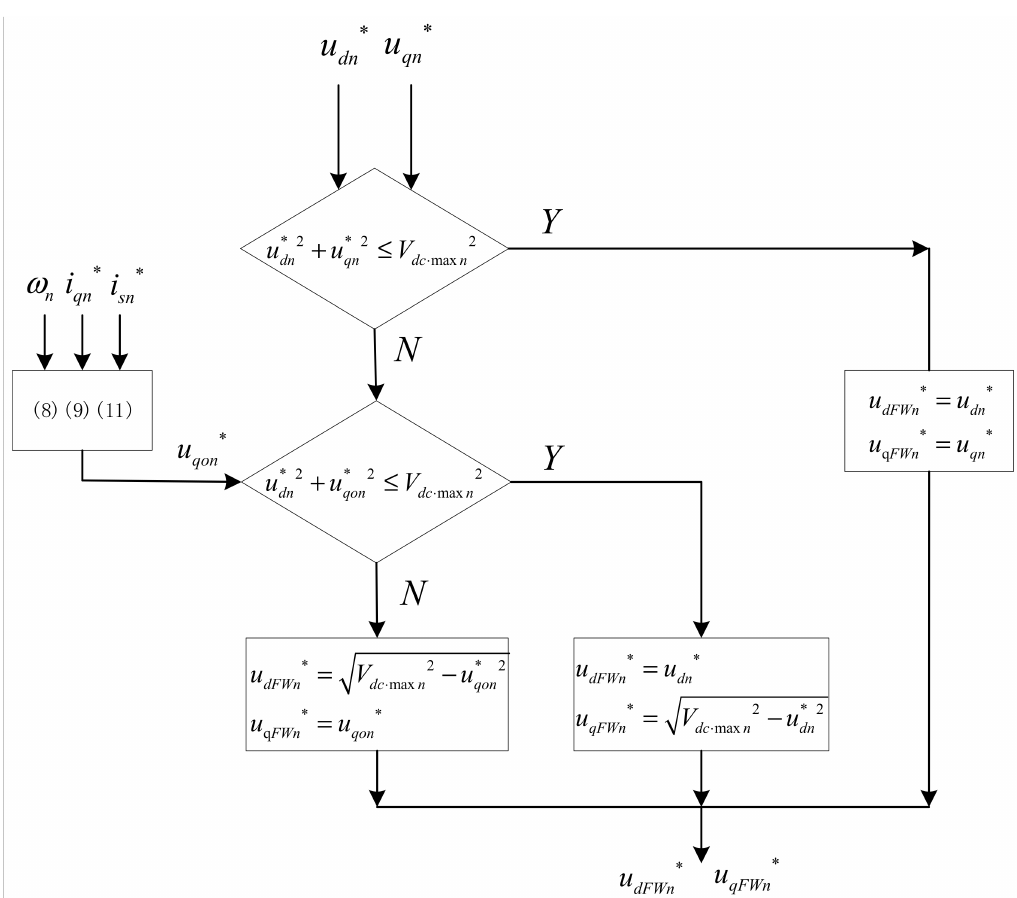
Figure 5. Control flow chart of voltage comment compensation.